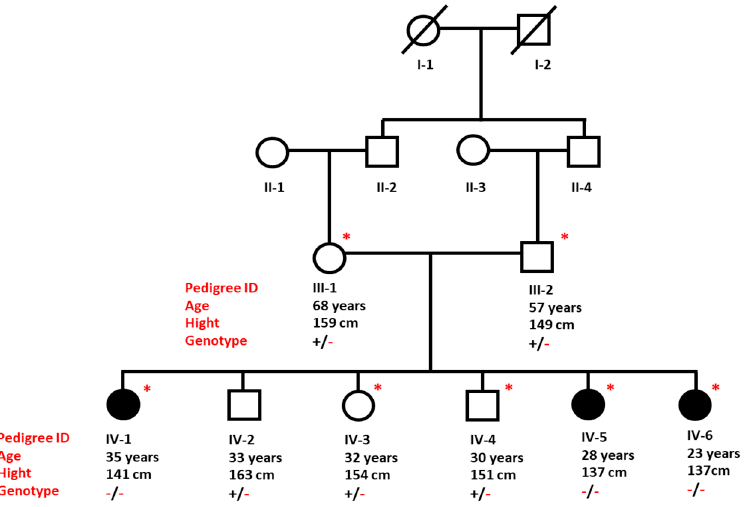
Figure 1. Pedigree of a Saudi family presenting inheritance of CPHD in an autosomal recessive pattern. Individuals marked with asterisks (*) are available for clinical and genetic